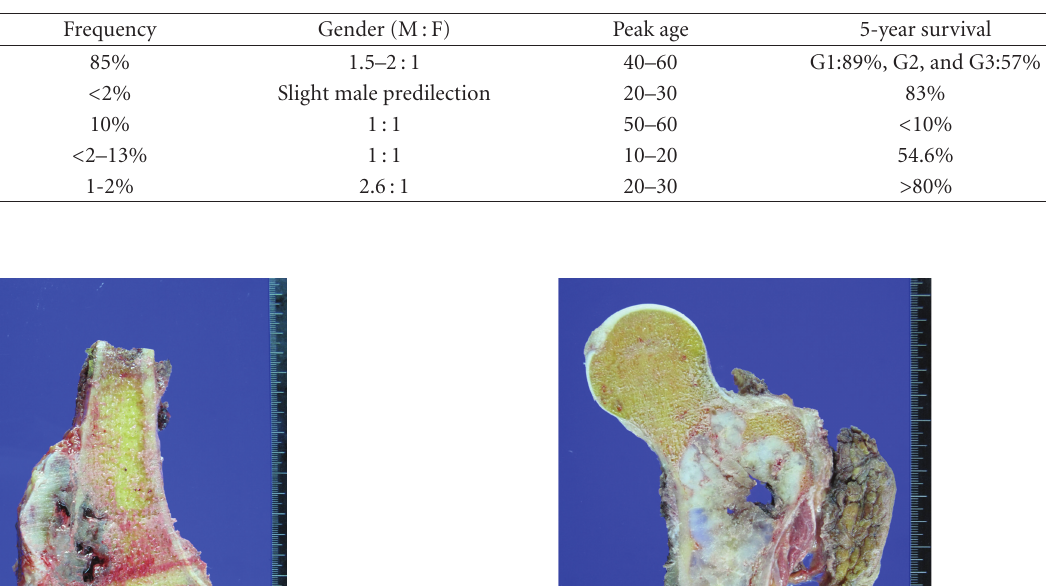
Table 2: Summary of frequency, age, sex, and prognosis of CHSs.